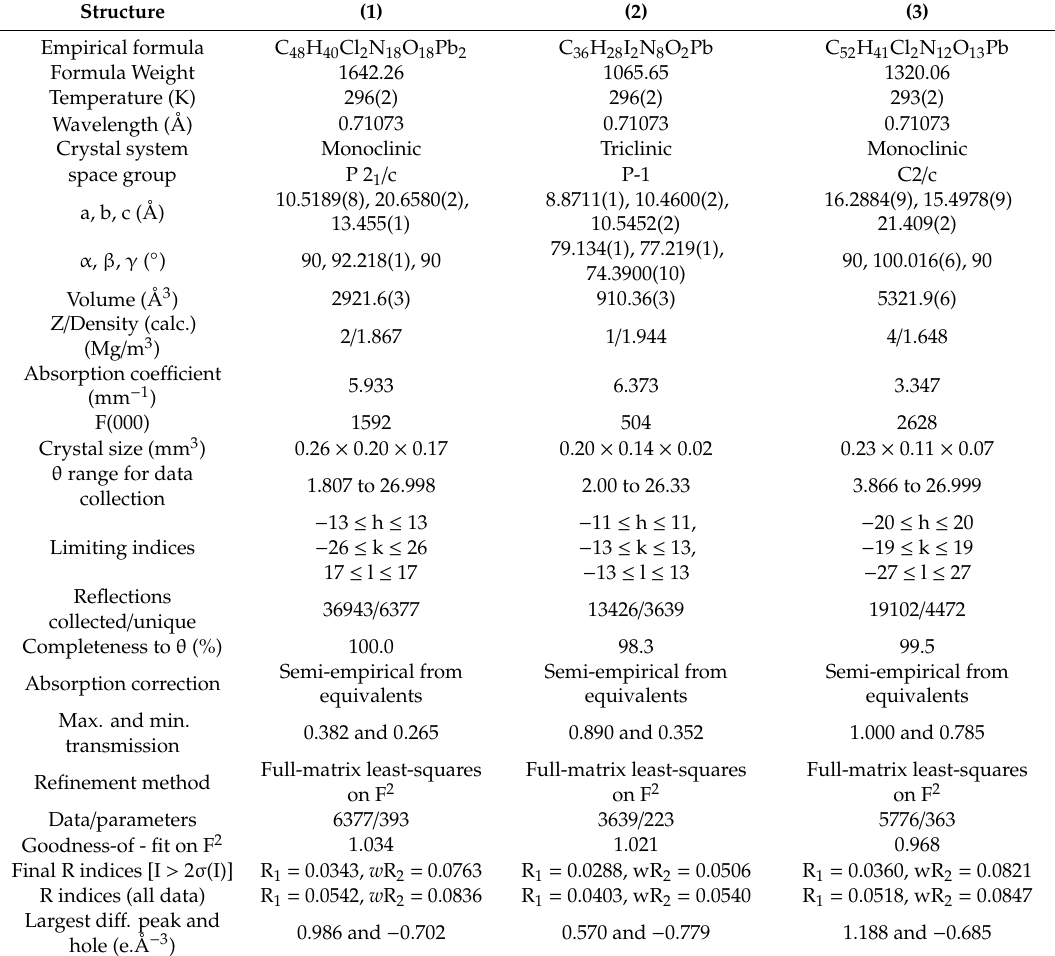
Table 1. Crystallographic data and structure refinement factors of ( 1 – 3